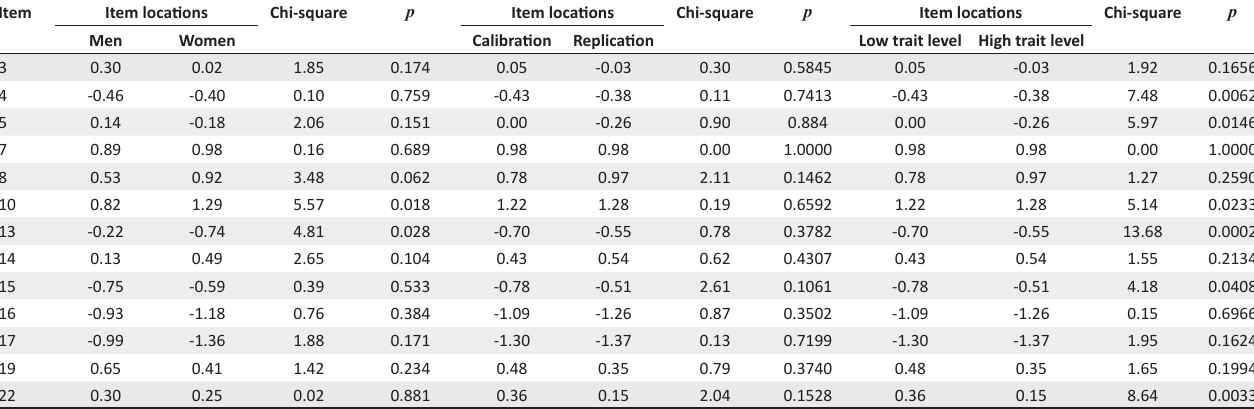
TABLE 3: Comparison of item locations across different groups. Item Item